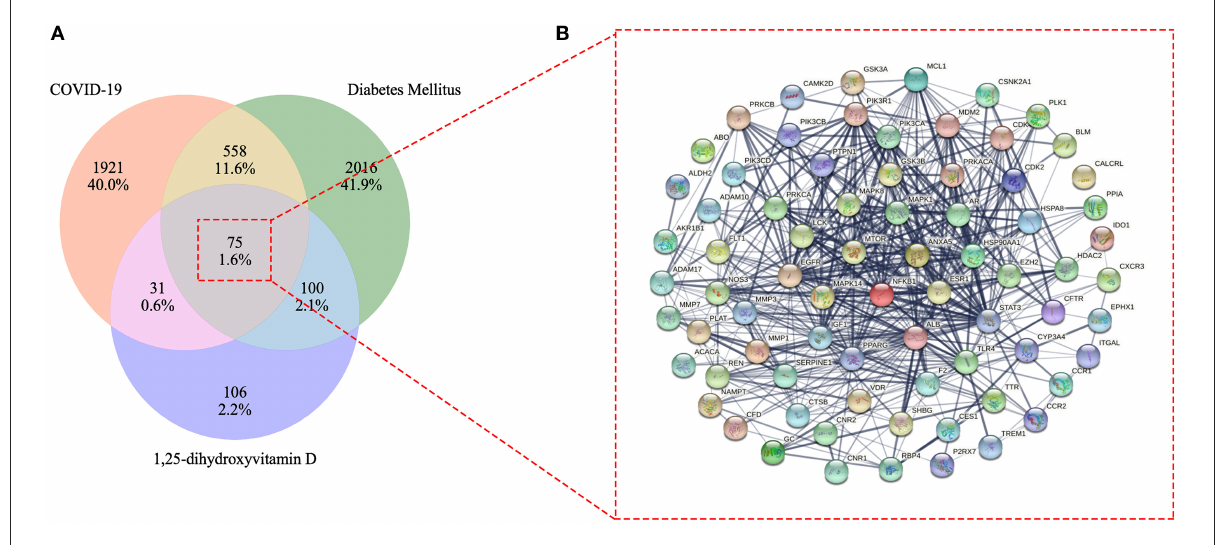
FIGURE3 Venn diagram of 1,25-dihydroxyvitamin D effects against COVID-19 and diabetes mellitus (DM) (A) . Mutual target genes of 1,25-dihydroxyvitamin D and COVID-19/DM for constructing a protein–protein interaction network (B) .